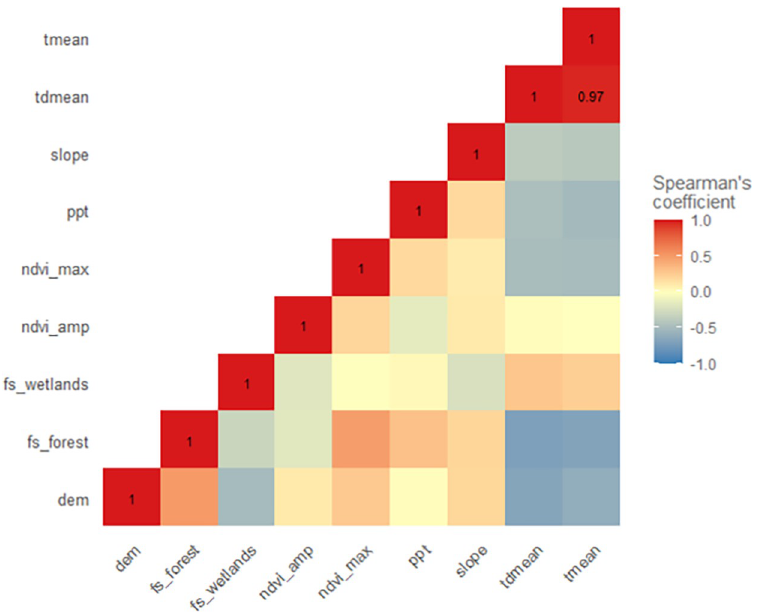
Fig 4. Boosted regression tree and random forest variable correlation matrix. tmean—mean temperature, tdmean —mean dewpoint temperature, slope—degree of slope, ppt—precipitation, ndvi_max—NDVI maximum, ndvi_amp— NDVI amplitude, fs_wetlands—wetlands focal statistics, fs_forest—forest focal statistics, dem—digital elevation